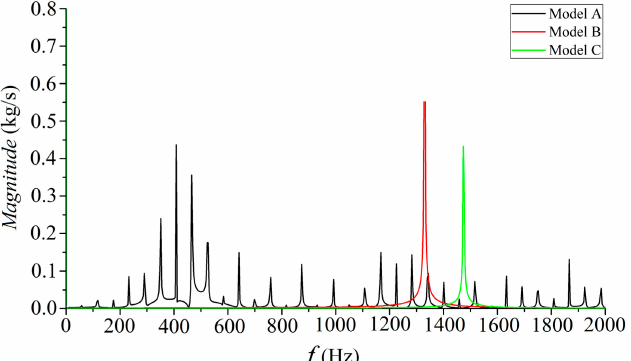
Figure 11. Spectrum analysis and comparison of different models.